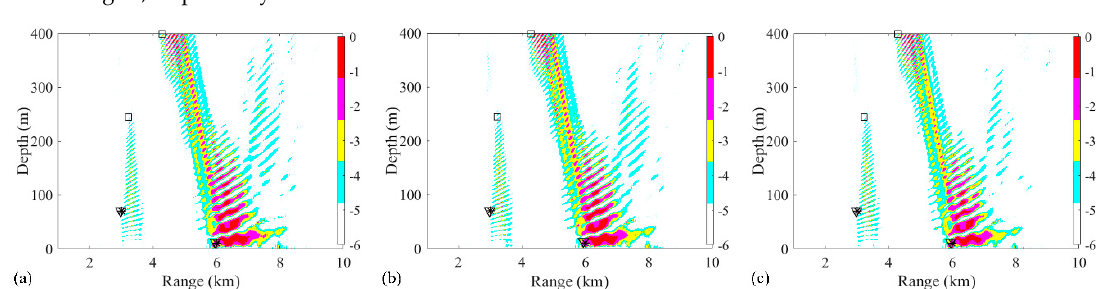
Figure 12. Ambiguity surfaces generated with 28 snapshots and a 32 element VLA using the RAMPMF method to localize sources at 70 m. The position of one source (3 km, 70 m) remains unchanged. The distances between two sources are ( a ) 1 km, ( b ) 1.5 km and ( c ) 2 km. True source positions and the positions estimated by RAMPMF methods are represented as black asterisks and inverted triangles, respectively.